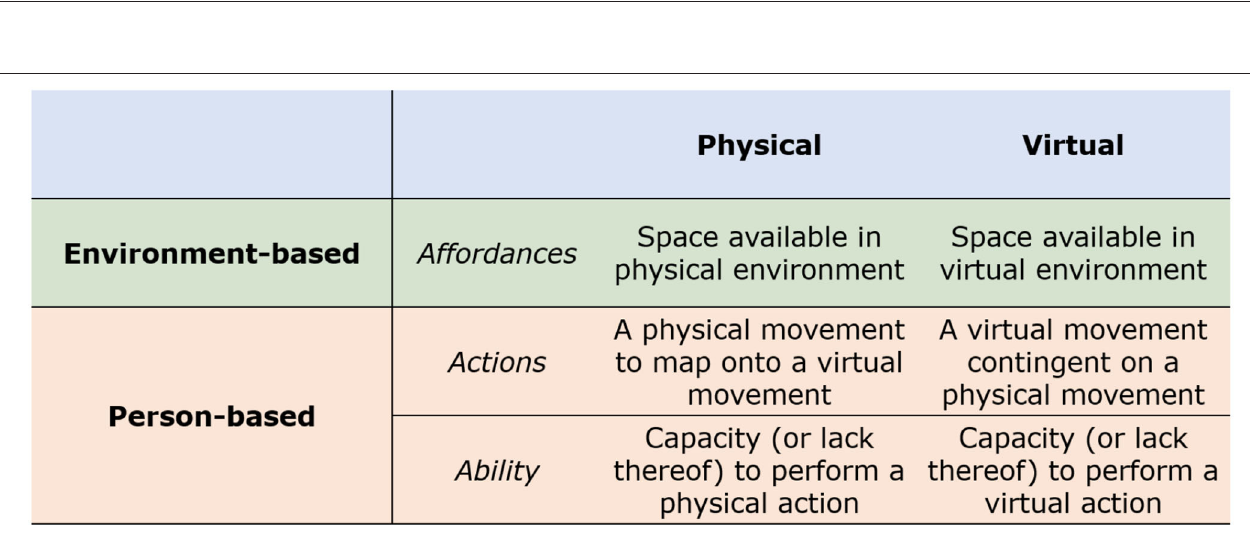
Frontiers in Psychology |